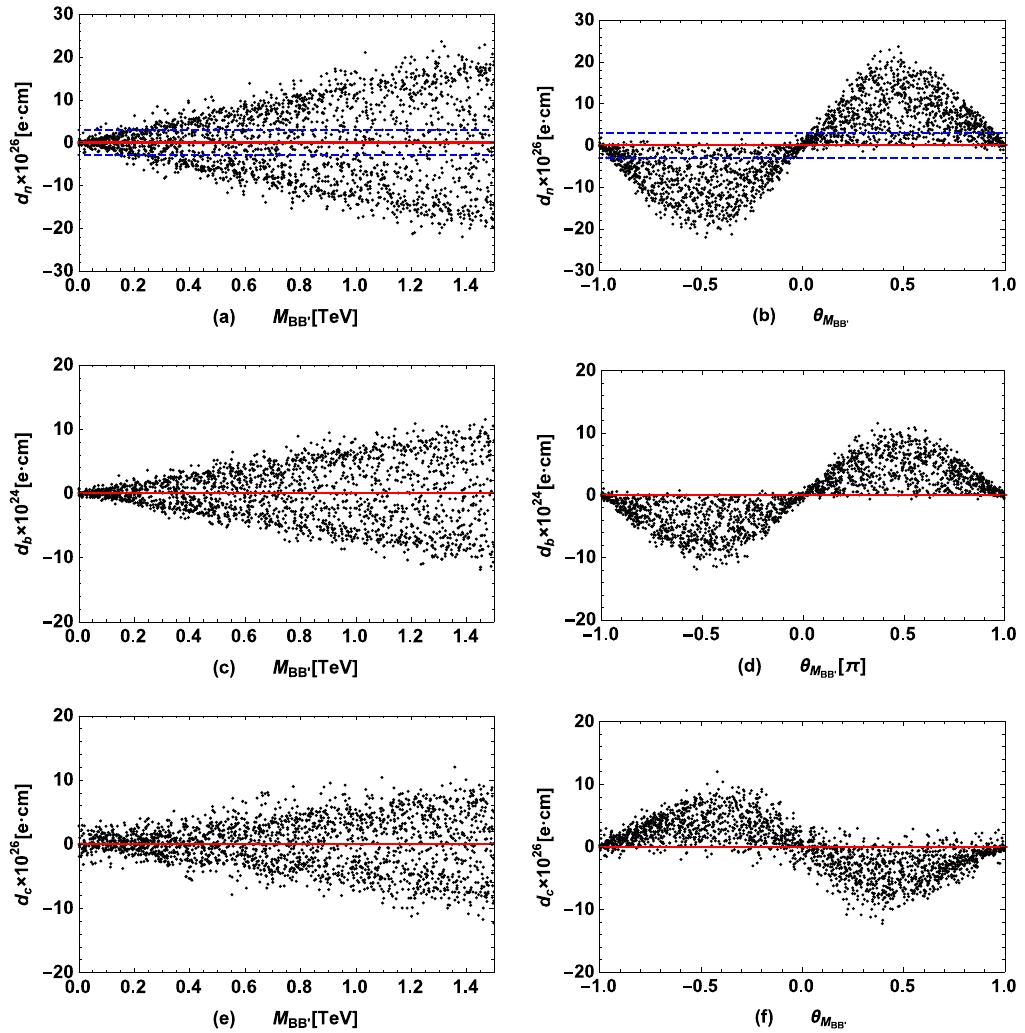
Figure 8 . Scanning the parameter space shown in eq. (4.4), d n , d b , d c versus M BB 0 , (cid:18) M plotted, where the red lines denote the corresponding MSSM predictions in the same parameter space, the blue dashed lines denote the experimental upper bound on d n